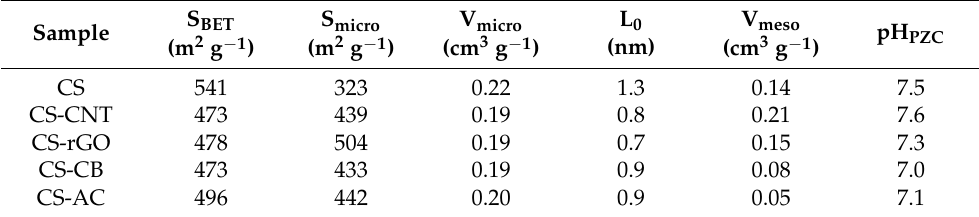
Table 1. Textural parameters and pH PZC for the different carbon supports.